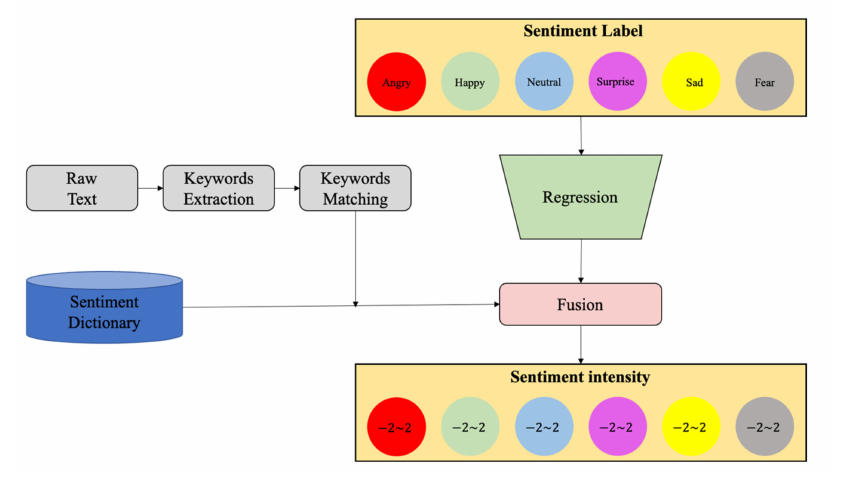
Figure 6. Reanalysis